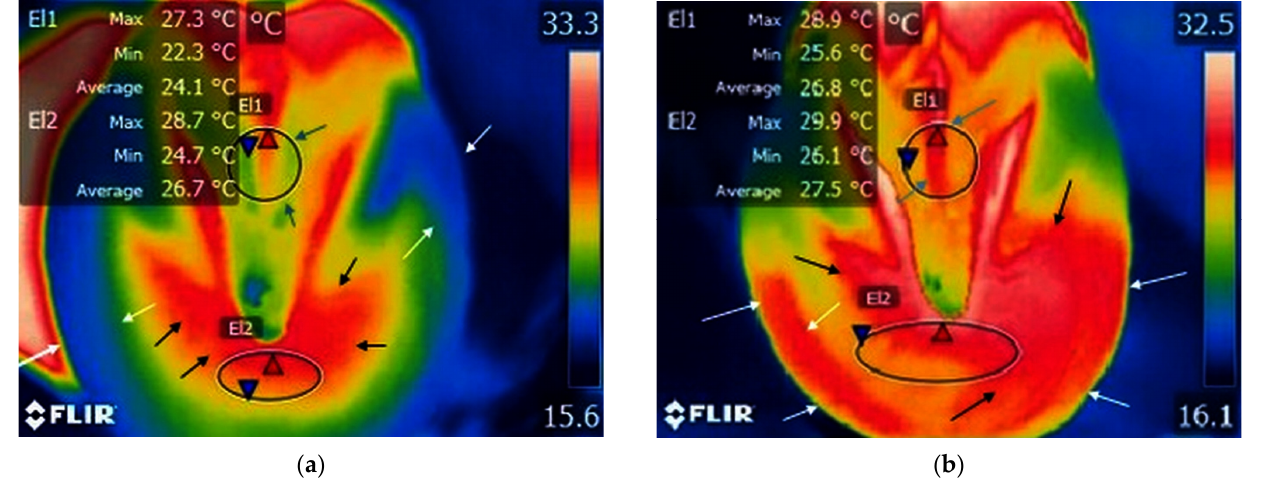
Figure 5. Control group: ( a ) small surface of increased temperature in the toe area (black arrows); small surface of increased temperature in the frog area (blue arrows); reduced temperature of the hoof wall (white arrows); minimum temperature recorded in the area—blue triangle spot; maximum temperature recorded in the area—red triangle spot; ( b ) increased local temperature and wider surface of increased temperature in the toe area (black arrows); increased local temperature and wider surface of increased temperature in the frog area (blue arrows); increased temperature along the hoof wall (white arrows); minimum temperature recorded in the area—blue triangle spot; maximum temperature recorded in the area—red triangle spot. Table 1. Descriptive statistics for minimum, maximum, and mean temperature for each group.